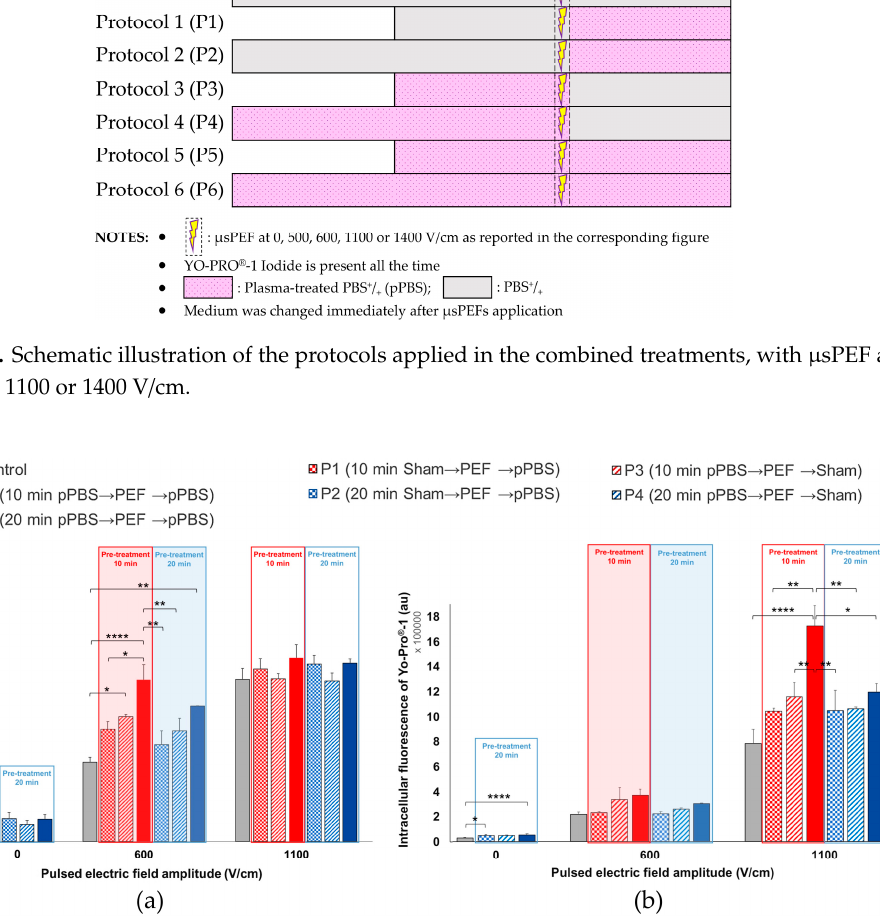
Figure 5. Effects of the combined treatment on DC-3F fibroblasts at 0, 600, and 1100 V/cm. ( a )